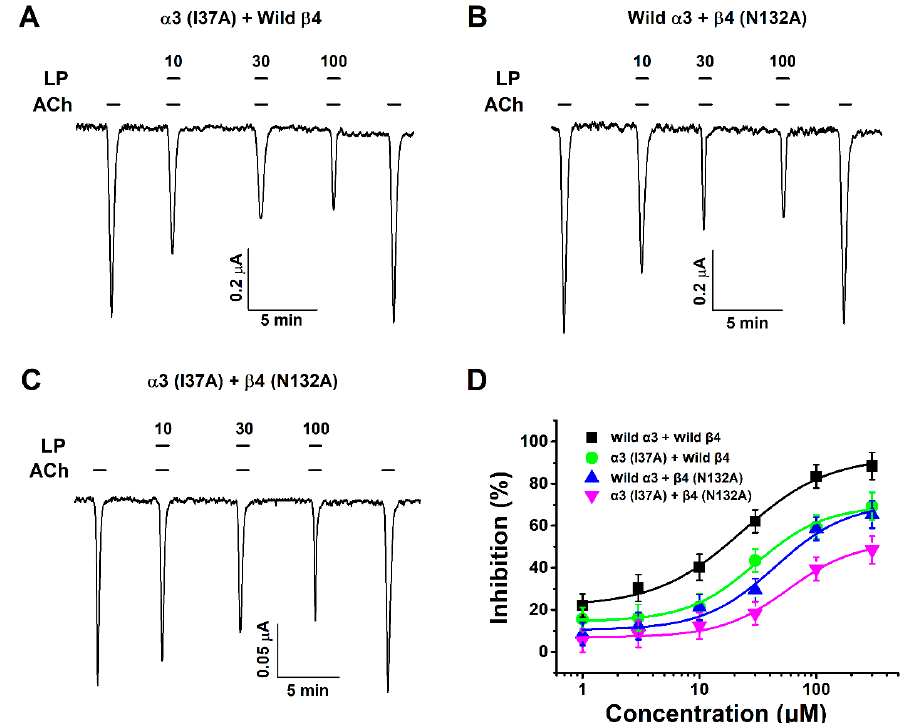
Figure 5. Effect of lupeol on double-mutant α 3 β 4 nicotinic acetylcholine receptors. ( A – C ) Inward currents of concentration–response relationship to coapplication of acetylcholine and lupeol with 10, 30, and 100 μ M concentrations of oocytes expressing α 3 (I37A) + Wild β 4, Wild α 3 + β 4 (N132A), and α 3 β 4 (I37A/N132A) nAChRs. ( D ) Concentration–response graphs showing effect of different concentrations of lupeol on mutant α 3 β 4 nACh receptors in presence of 100 μ M acetylcholine. Each point is mean ± SEM ( n = 6–7 from three different frogs). Additional half-inhibitory concentration, Hill coefficient, and I max values described in Table 1. Table 1. Effects of lupeol on subunit mutants of α 3 β 4 nicotinic acetylcholine receptors.